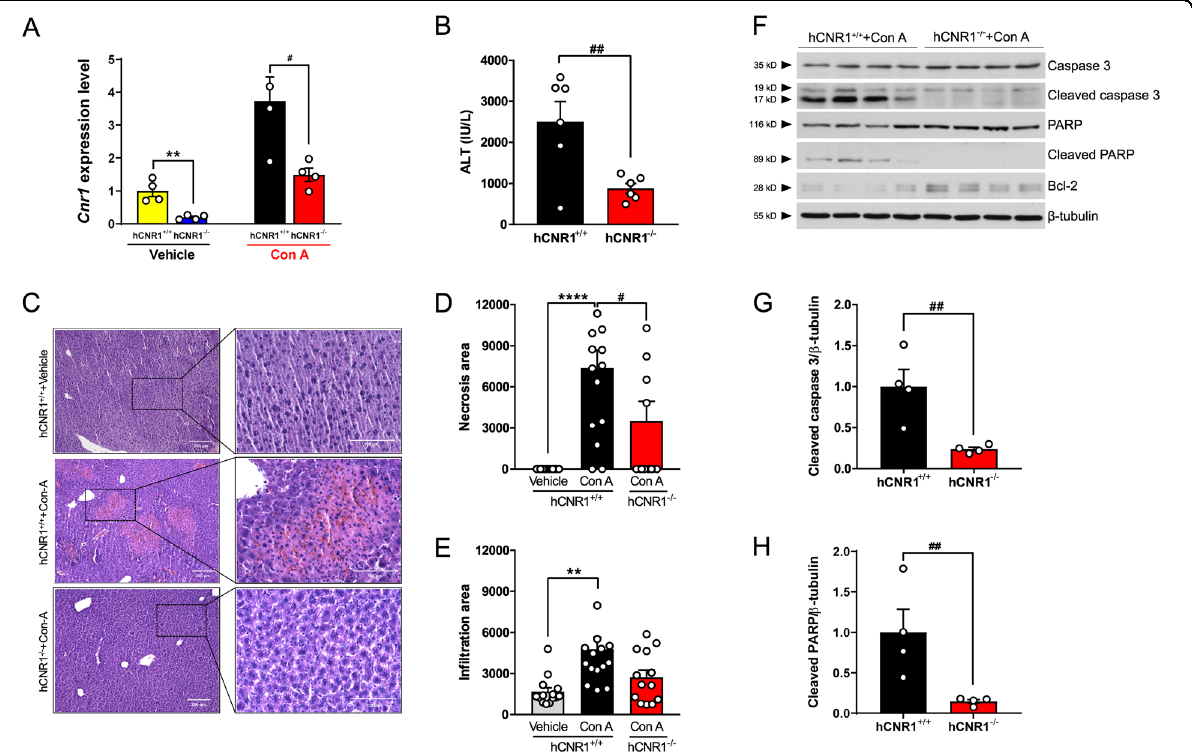
Fig. 2 Nulli fi cation of hepatic CB1R ameliorates liver damage via anti-apoptotic signaling. A Cnr1 in liver from hCNR1 + / + and hCNR1 − / − mice with or without Con A (5 mg/kg) injection ( n = 4 – 5) for 12 h. B Plasma alanine aminotransferase (ALT) levels (IU/L) in Con A-administered hCNR1 + / + and hCNR1 − / − mice ( n = 6 per each group). C – E H&E staining (×10 (left, scale bars, 200 μ m) and ×40 (right, scale bars, 100 μ m) magni fi cations) and quanti fi cations of the percentage of the average area of in fl ammatory cells in fl ammation ( D ) and hepatocyte necrosis ( E ) after 5 mg/kg of Con A administration for 12 h. F Protein expression levels in liver tissue lysates post-injection of 5 mg/kg of Con A administration for 12 h ( n = 4) and quanti fi cation for cleaved caspase 3 ( G ) and poly (ADP-ribose) polymerase (PARP) ( H ). Values were normalized to β -tubulin. Results were expressed as mean ± S.E.M. (* p ≤ 0.05, ** p ≤ 0.01, **** p ≤ 0.0001 compared to Control; # p ≤ 0.05, ## p ≤ 0.01, ### p ≤ 0.001 compared to hCNR1 + / + + Con